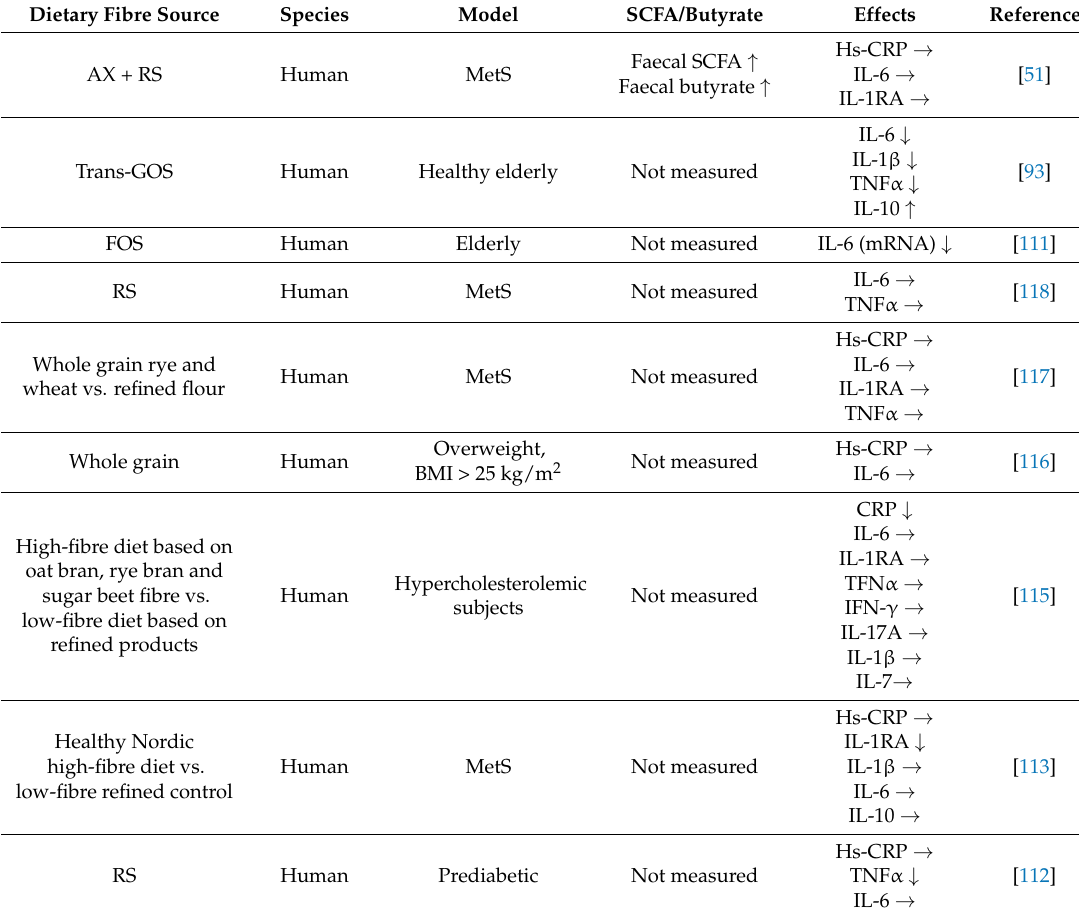
Table 3. Overview of effects of increased short-chain fatty acids and butyrate production and parameters related to systemic